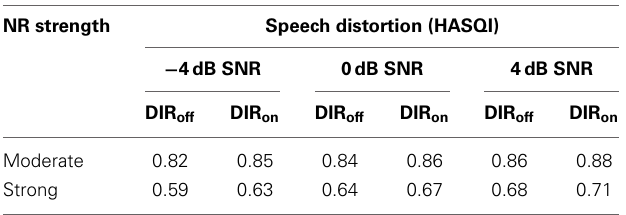
Table 3 | Speech distortion (as measured using HASQI) caused by moderate and strong NR for the omnidirectional (DIR off ) and cardioid (DIR on ) settings and input SNRs of − 4, 0, and